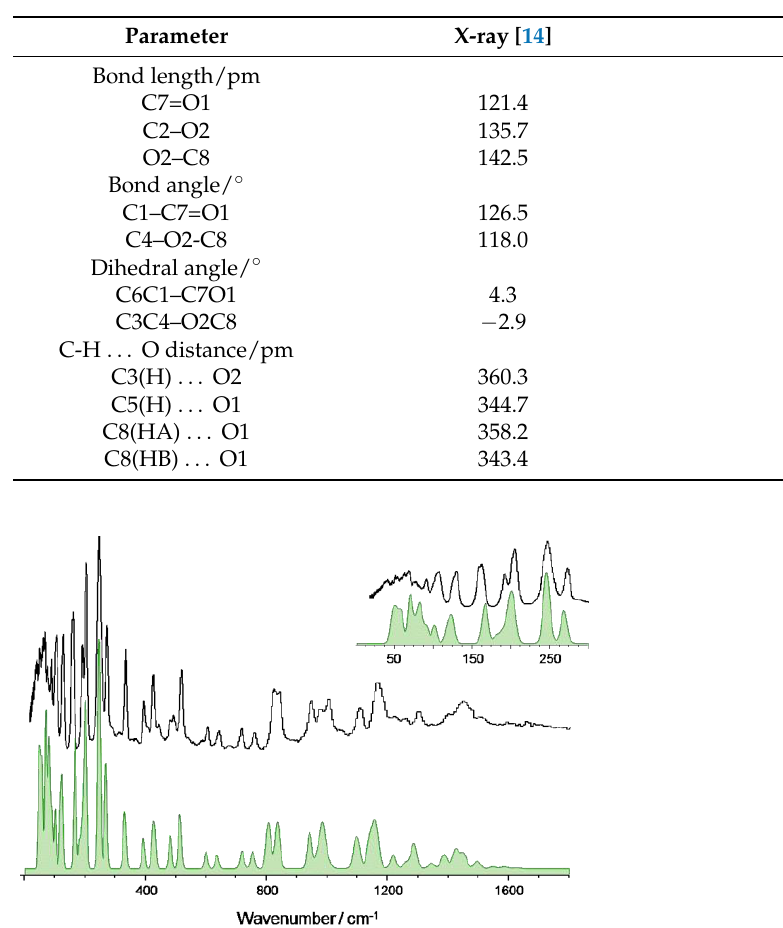
Table 3. Selected geometrical parameters for 4MeOB.